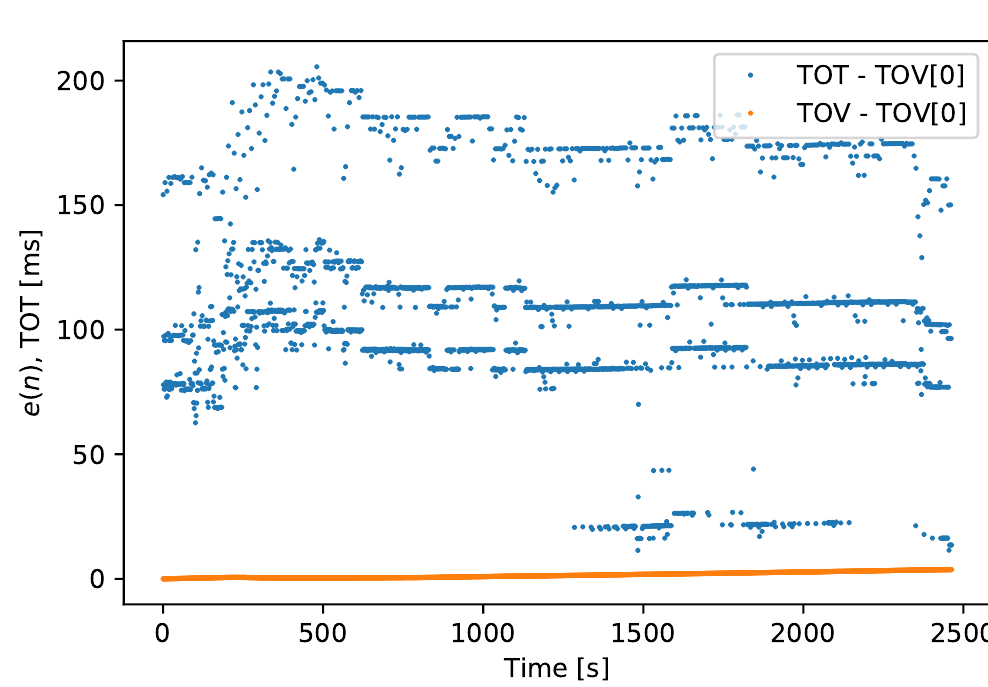
Figure 15. e ( n ) for TOT vs. TOV, measured in